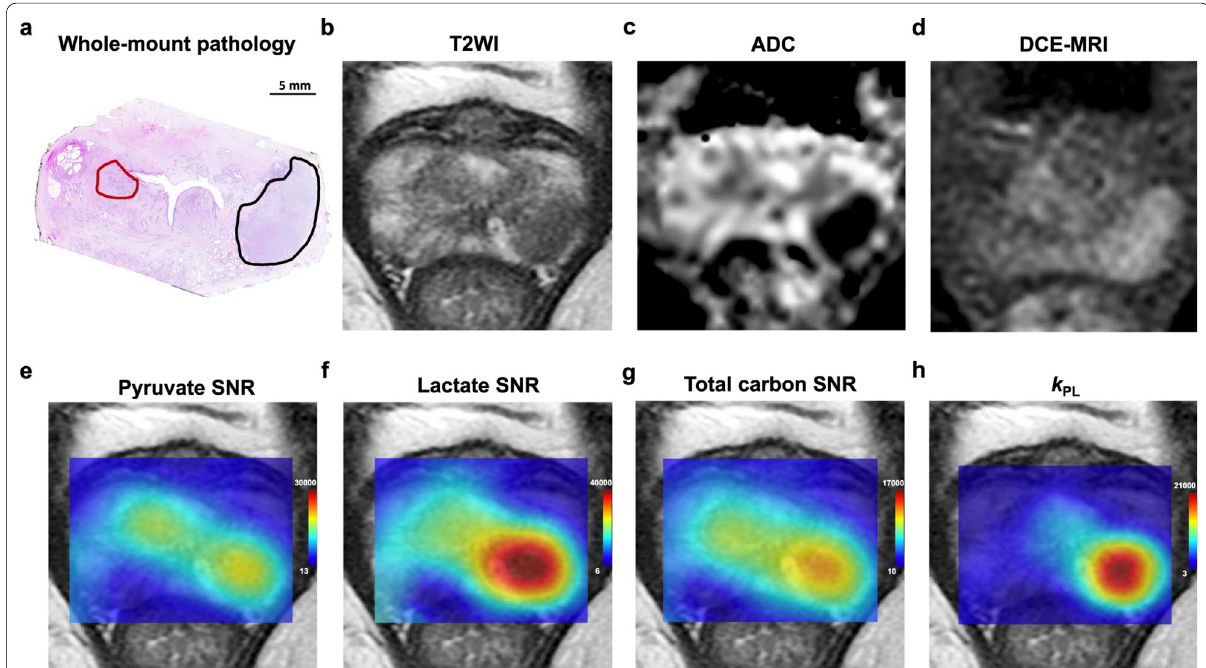
Fig. 5 Representative example of an MR-occult transition zone tumor detected on hyperpolarized 13C-MRI. a Post-surgical histopathological assessment confirmed the diagnosis of multifocal adenocarcinoma of the prostate. An International Society of Urological Pathology (ISUP) grade 3 target lesion was visible on 1H-MRI in the left peripheral zone: Prostate Imaging-Reporting and Data System (PI-RADS) 5 target lesion; black region of interest (ROI). b Standard-of-care T2-weighted MRI demonstrating a marked area of low signal intensity corresponding to the target lesion in the left peripheral zone. c ADC map demonstrating a corresponding focus of markedly restricted diffusion in the left peripheral zone. d Dynamic contrast-enhanced (DCE) MRI demonstrating the area of early enhancement in the left peripheral zone. e Pyruvate signal-to-noise ratio (SNR) map with two areas of high pyruvate signal, both corresponding to histopathology-confirmed tumor foci. f Lactate SNR map demonstrating high [1-13C] lactate signal in the grade 3 left peripheral zone lesion. g Total carbon SNR map showing higher signal in the left peripheral zone tumor. h K pl map (presented as s 1) showing a higher rate of pyruvate-to-lactate conversion in the more aggressive left peripheral zone lesion. Nat Commun. 2022 − Jan